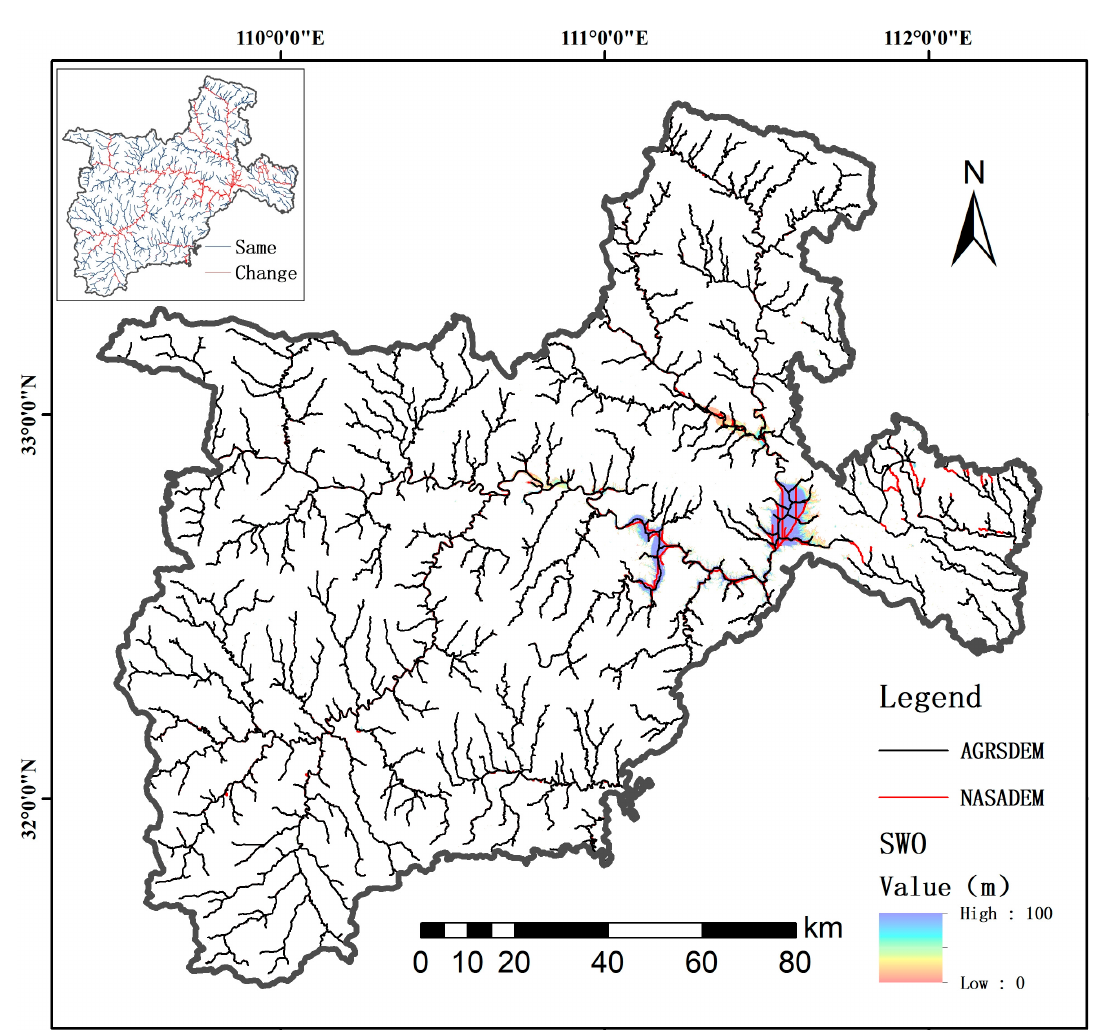
Figure 7. River network of AGRSDEM and NASADEM (the blue and red lines are the river network based on AGRSDEM and NASADEM, respectively).